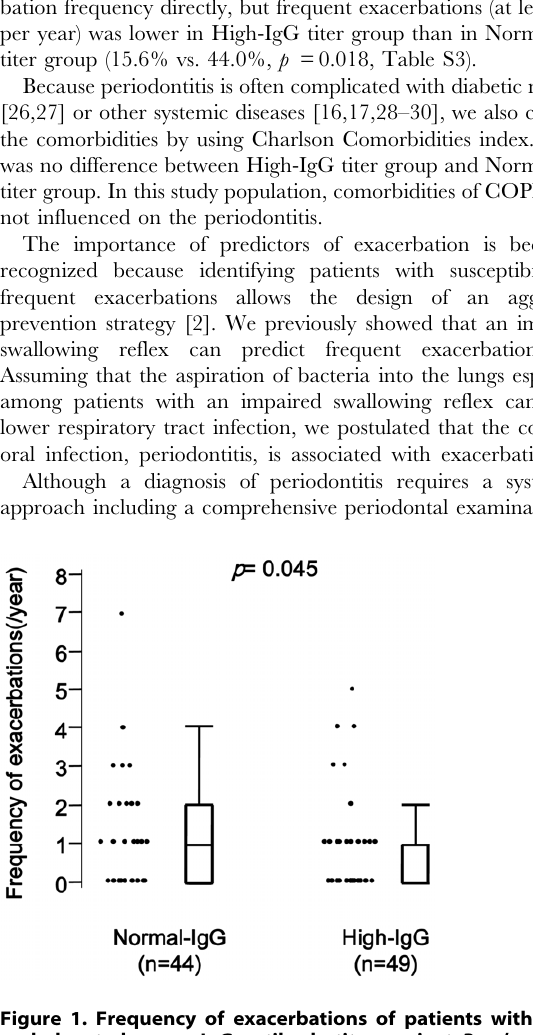
Figure 1. Frequency of exacerbations of patients with COPD and elevated serum IgG antibody titer against